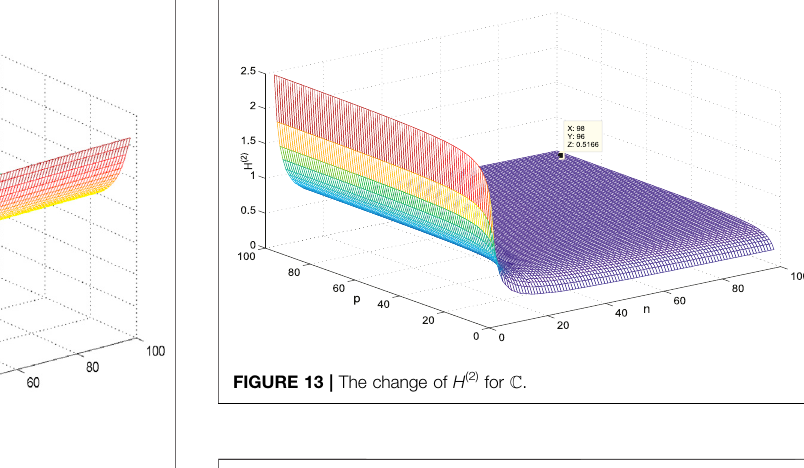
FIGURE 10 | The change of H (1) for D .